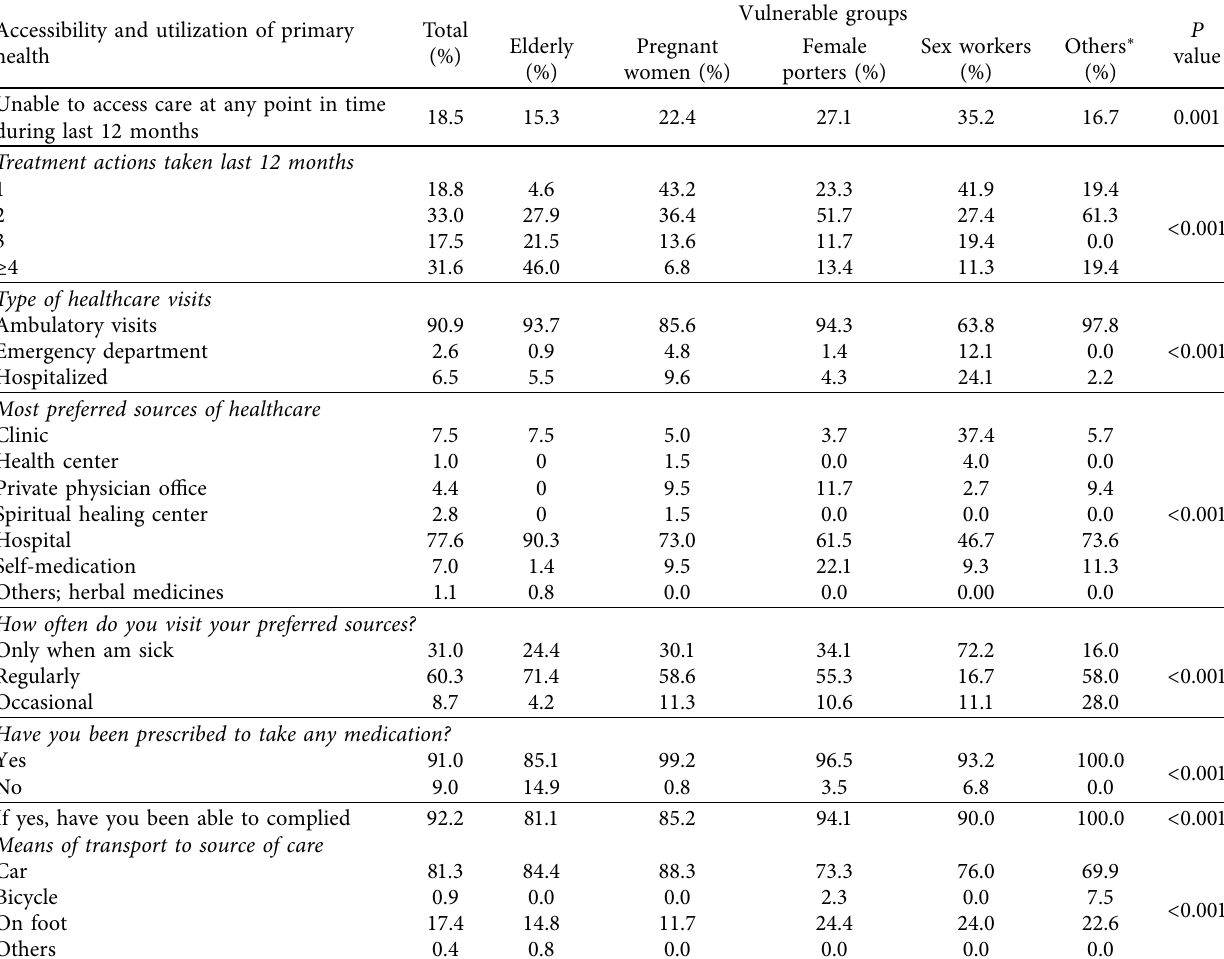
Table 2: Accessibility and utilization of primary healthcare among vulnerable